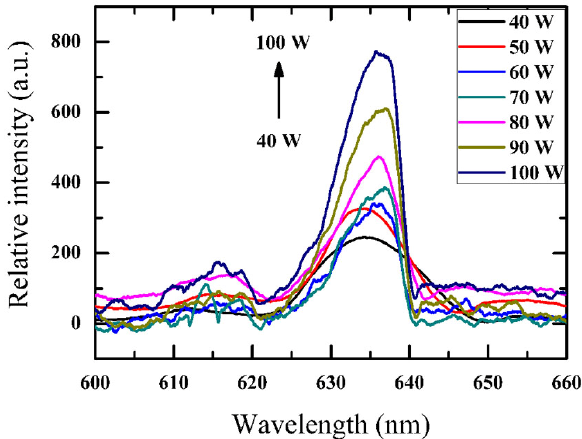
Figure 3. The mechano-luminescent output spectrograph of the composite under different vibration